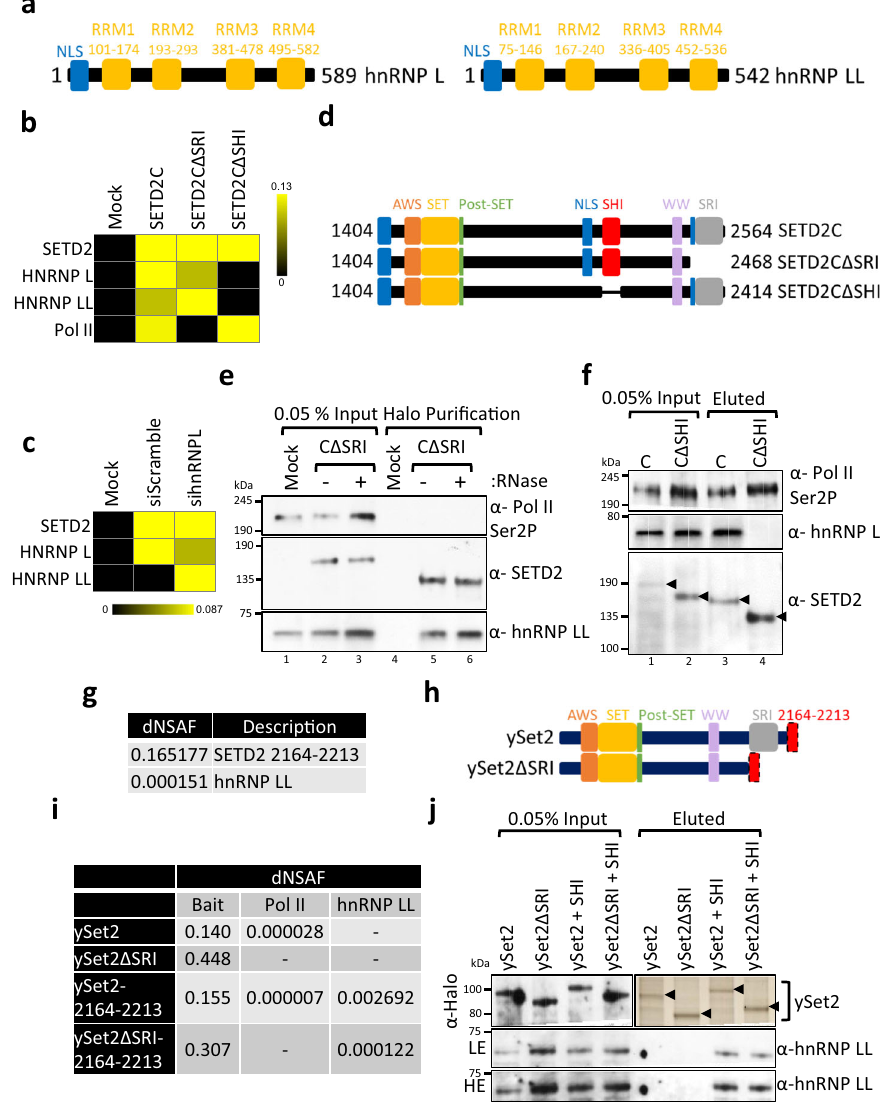
Fig. 3 SETD2 binds to hnRNP LL through its SHI Domain. a , d , h Cartoon illustrating the domain organization of hnRNP L, hnRNP LL, SETD2, and ySet2. b , c Heat maps showing the enrichment of proteins normalized to the bait (SETD2C) in MudPIT analysis. e , f , j Western blotting and silver staining of af fi nity-puri fi ed complexes of Halo-SETD2C or Halo-ySet2 and its mutants from 293 T extracts. The experiment was repeated at least three times all yielding similar results. Source data are provided as a Source Data fi le. g , i Table showing the dNSAFs of the listed proteins post mass spectrometry analysis of puri fi ed complexes obtained by af fi nity puri fi cation of Halo-SETD2 or ySet2 from 239 T extracts. AWS associated with SET, SET-Su(var)3-9 enhancer-of-zeste and trithorax, SRI – Set2 – Rpb1 interaction, SHI – SETD2 – hnRNP interaction dNSAF distributed normalized spectral abundance factor, NLS nuclear localization encompassing